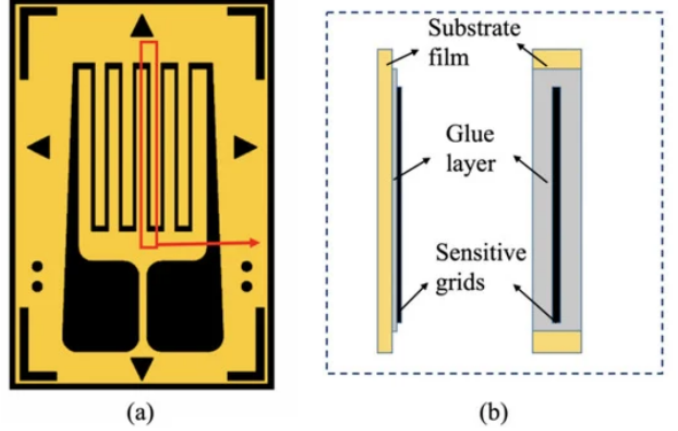
Figure 5. Front ( a ) and side ( b ) views of the typical structure of a resistive metallic strain gauge. Figure reproduced from